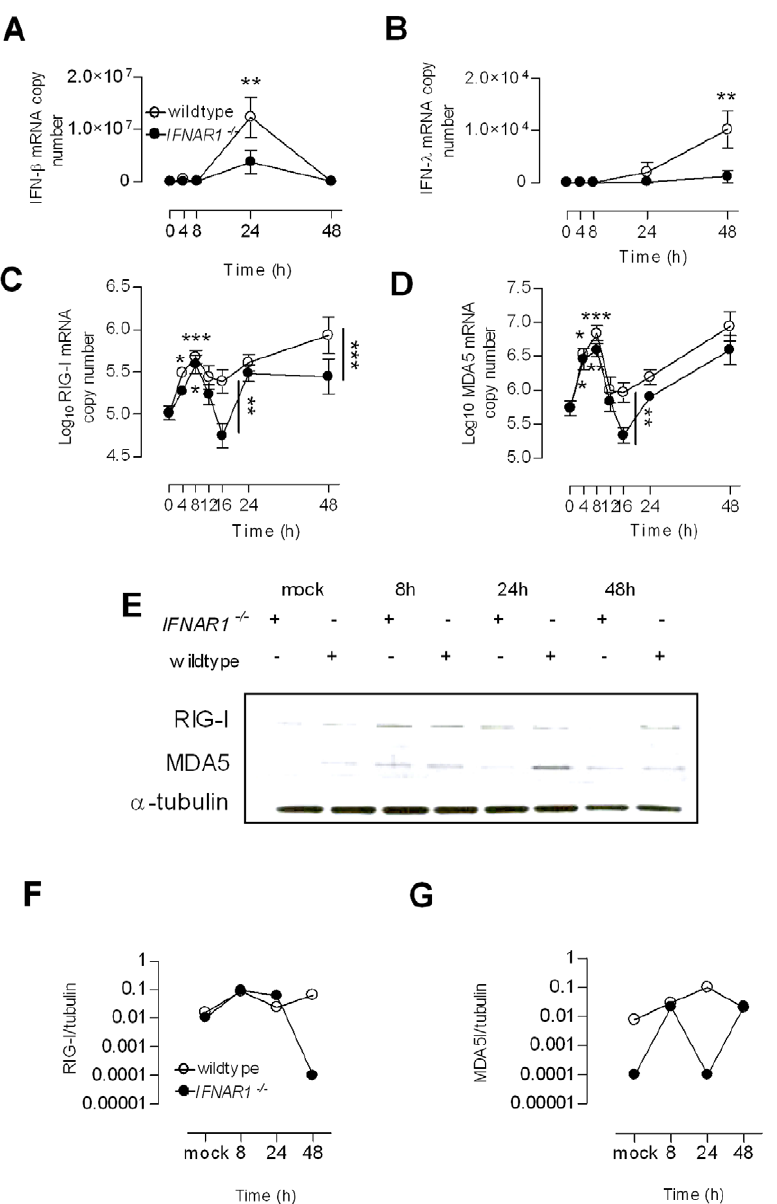
Figure 9. Expression of RIG-I and MDA5 mRNA and protein in wildtype and IFNAR1 deficient mice. Wildtype 129/SvJ and IFNAR1 2 / 2 mice were infected with RV1B and lung protein and mRNA analysed over time. In wildtype mice, and to a lesser extent, IFNAR1 2 / 2 mice, RV1B induced IFN- b mRNA (A), and IFN- l mRNA only in wildtype mice (B), and induced RIG-I in both wildtype and IFNAR1 2 / 2 mice (C). RV1B also induced MDA5 in both wildtype and IFNAR1 2 / 2 mice (D). In both wildtype and IFNAR1 2 / 2 mice, RIG-I and MDA5 mRNA induction was evident by 8 h post infection. RV1B also induced RIG-I and MDA5 protein by 8 h in both wildtype and IFNAR1 2 / 2 mice, measured by western blot (E), and RIG-I and MDA5 protein as a ratio of a -tubulin protein measured by densitometry over time is also shown (F&G respectively) * p , 0.05, ** p , 0.01 *** p , 0.001 versus time 0 h or as indicated.